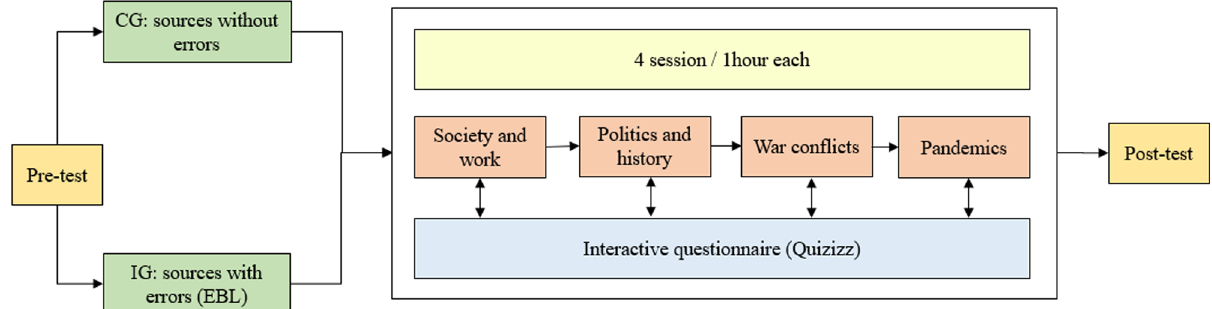
Fig. 2 Pedagogical dynamic implemented during each session in both groups. CG control group, IG intervention group and EBL error-based learning.